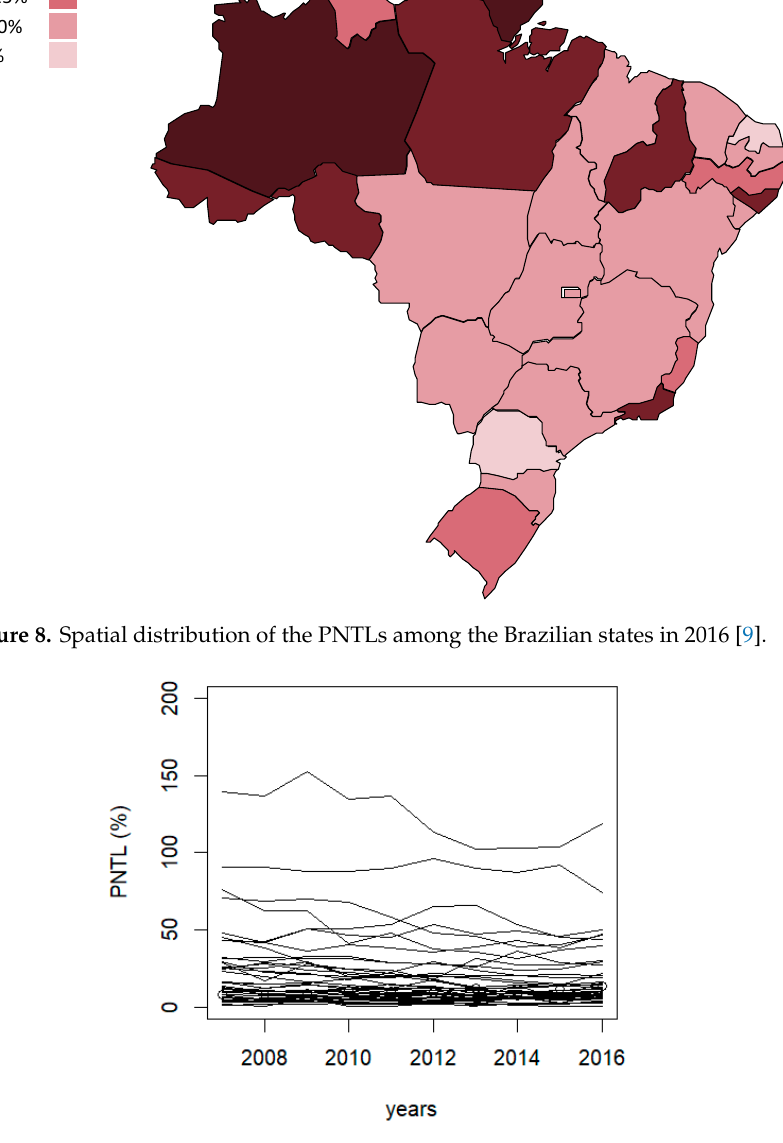
Table 1. The explanatory variables used in the application of stochastic frontier analysis (SFA) and the panel data econometric model specified by the National Electric Energy Agency (ANEEL) [10].